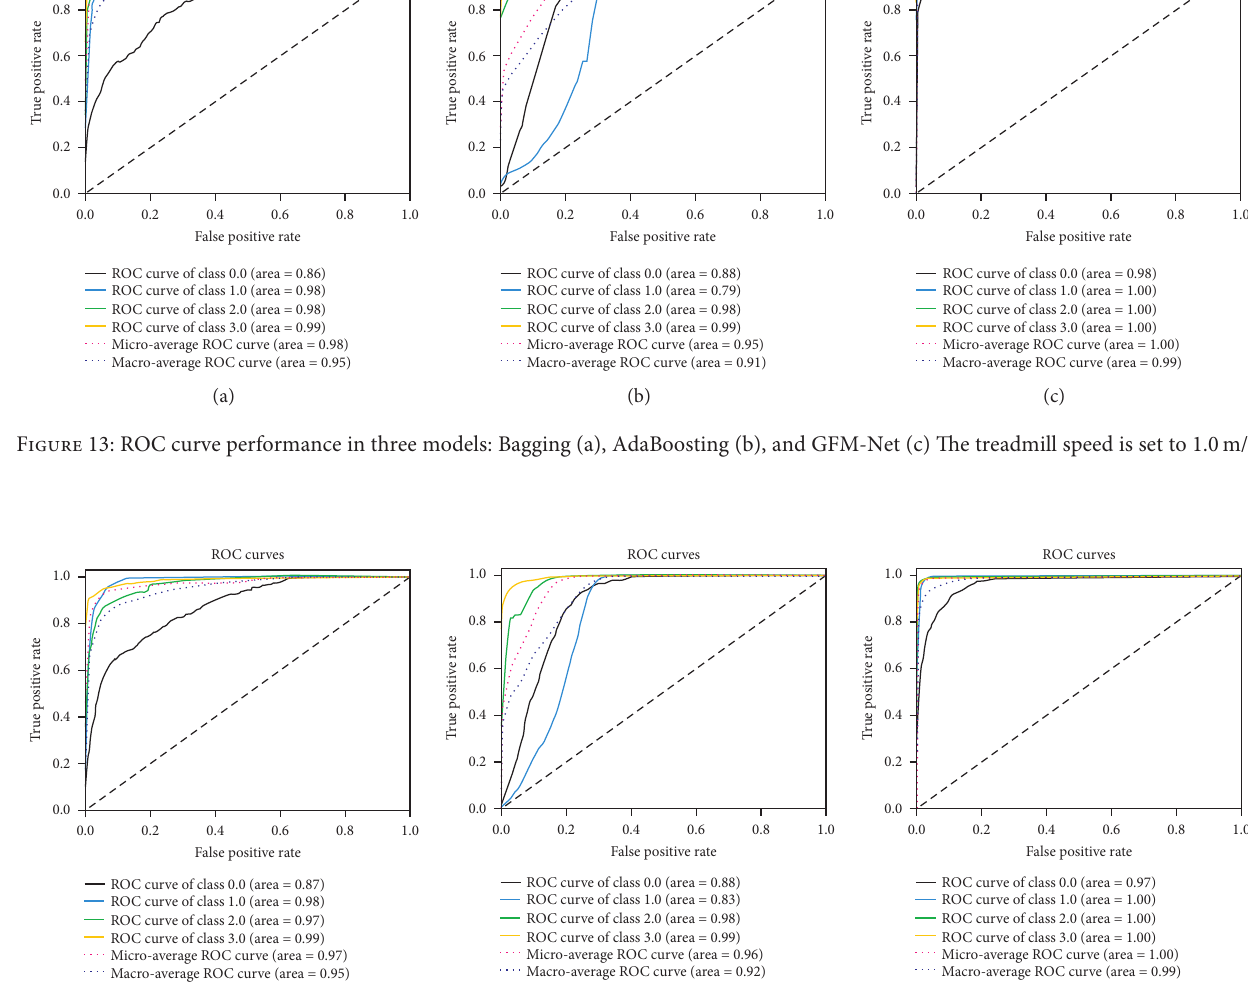
ROC curve of class 0.0 (area = 0.87) ROC curve of class 1.0 (area = 0.98) ROC curve of class 2.0 (area = 0.97) ROC curve of class 3.0 (area = 0.99) Micro-average ROC curve (area = 0.97) Macro-average ROC curve (area = Figure 14: ROC curve performance in three models: Bagging (a), AdaBoosting (b), and GFM-Net (c). The treadmill speed is set to